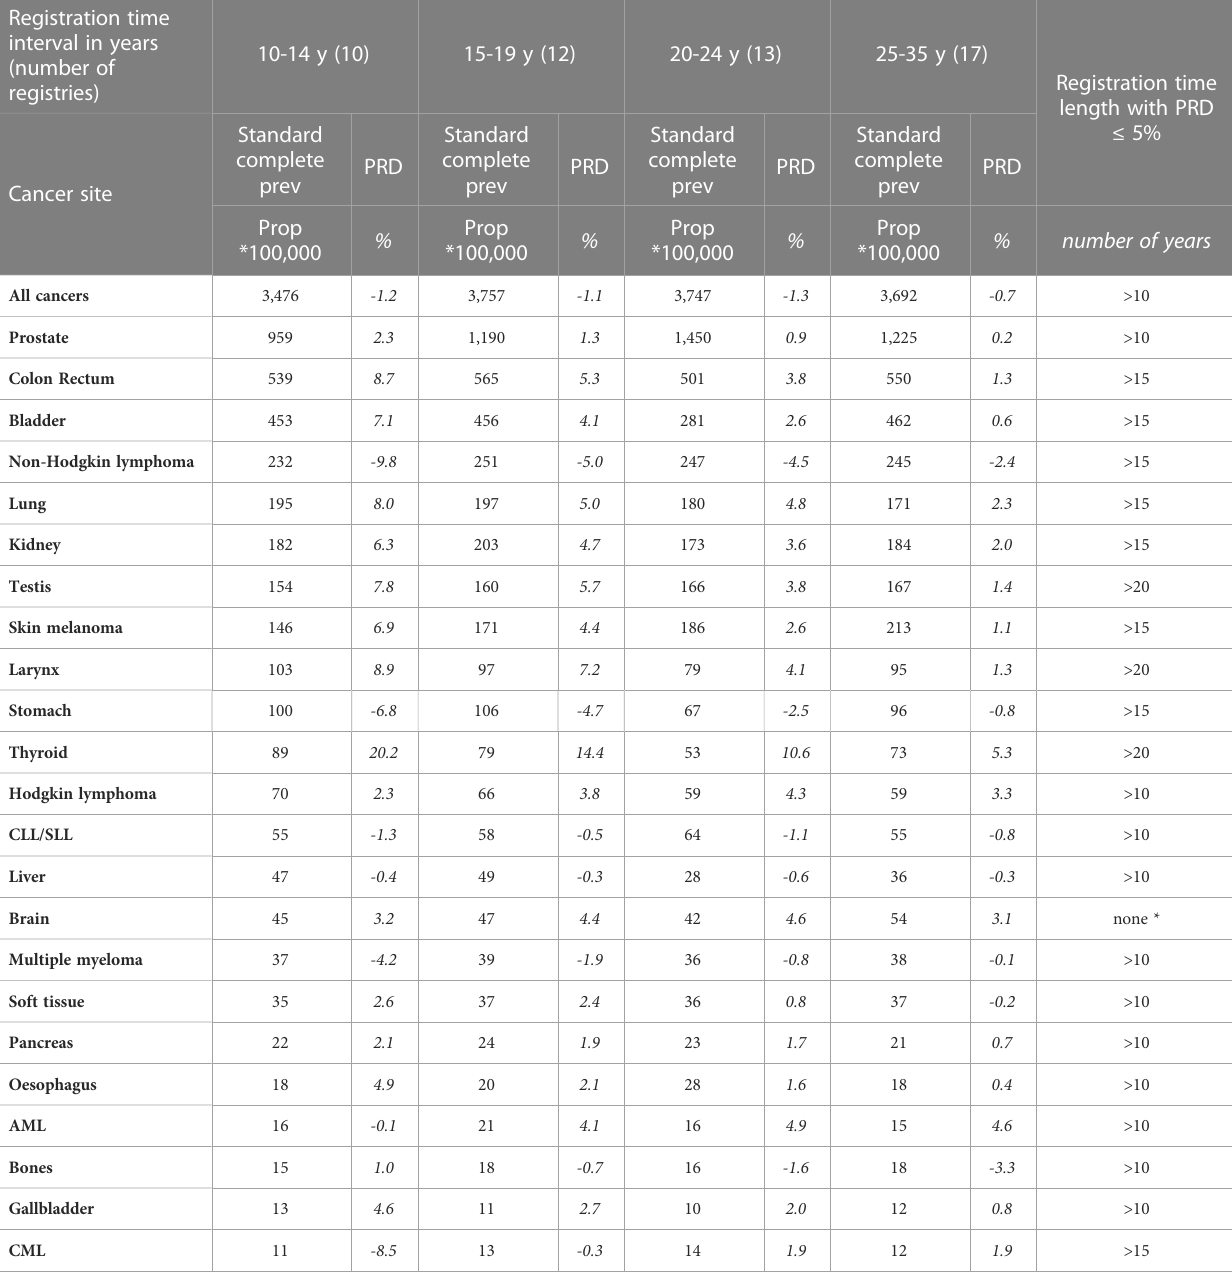
TABLE 4A Comparison between SEER and standard model-based complete prevalence at 1/1/2013 by cancer site for the 62 European registries included in the study grouped by registration time length (from 10-14 years to 25-35 years),